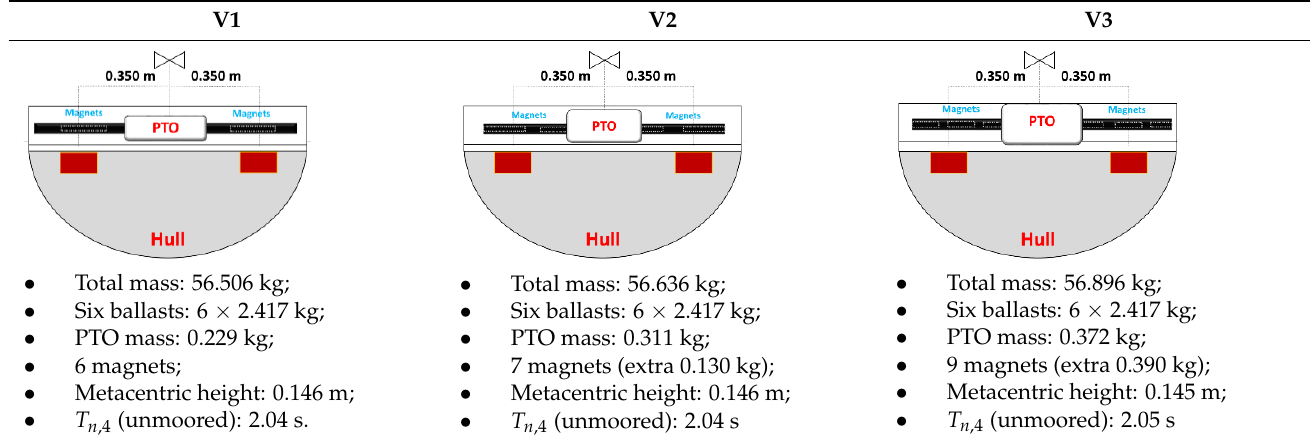
Table 4. Summary of the sub-variants for each E-Motions physical models. V1